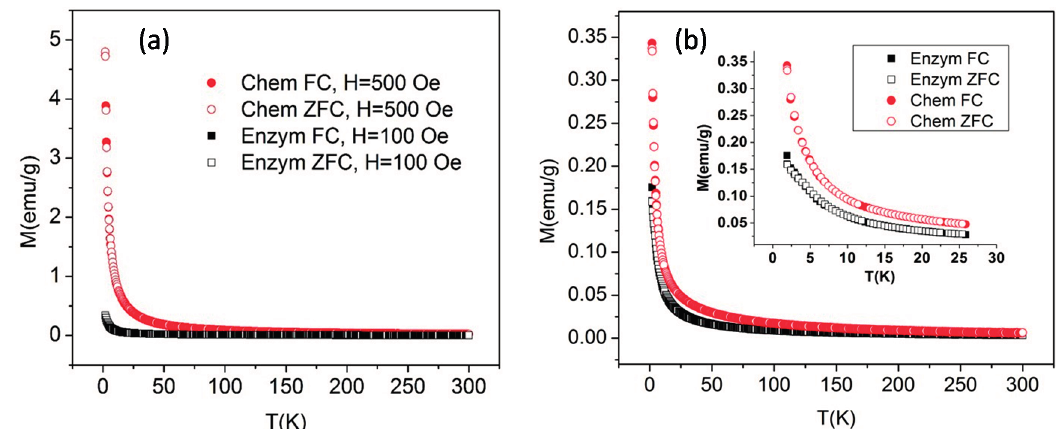
Figure 12. Zero-Field-Cooling (ZFC, open symbols) and Field-Cooling (FC, solid symbols) curves for ( a ) Fe–Gd–O and ( b ) Fe–Ho–O